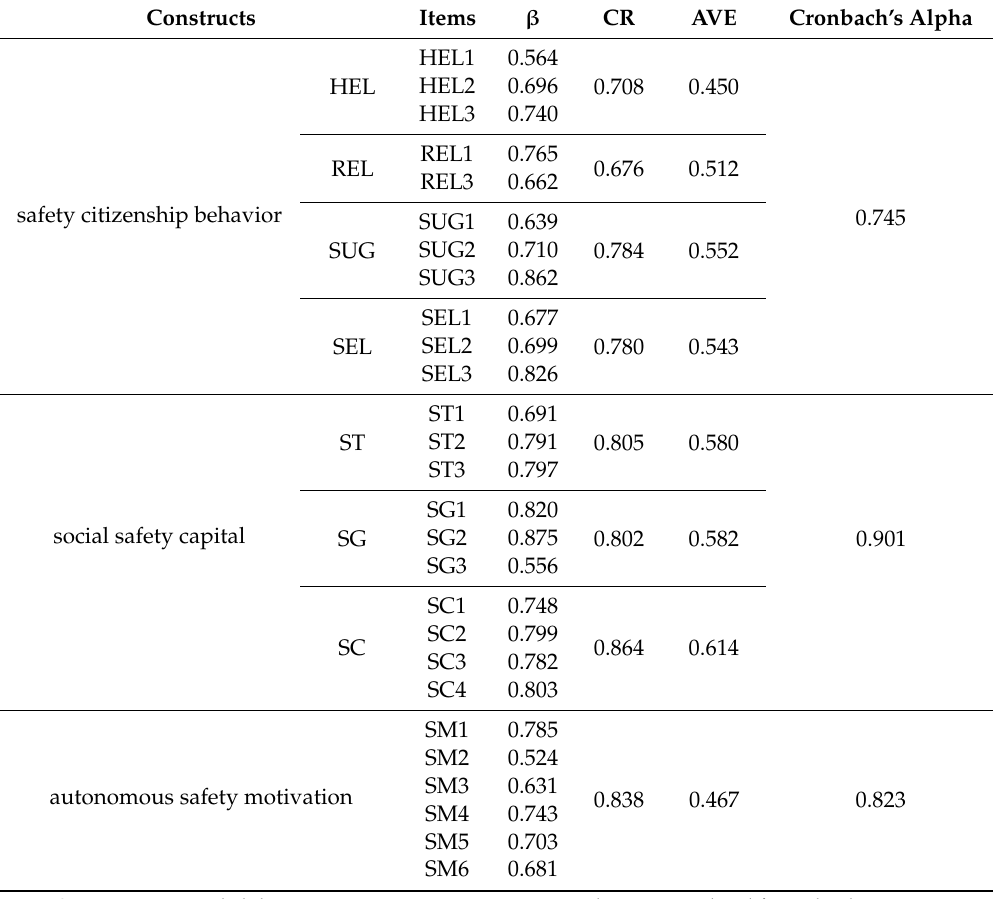
Table 4. Validation factor analysis and reliability output